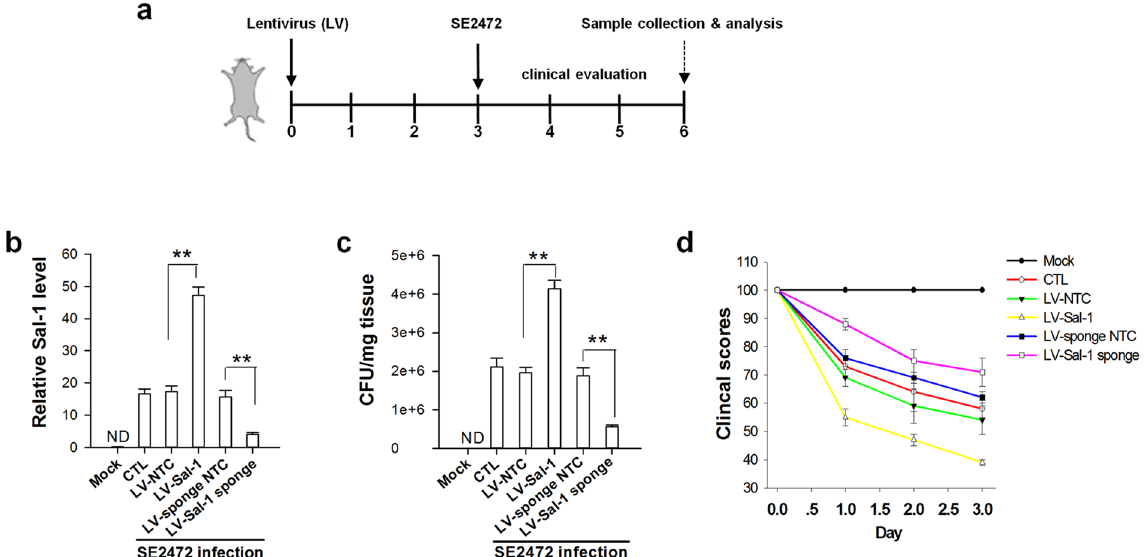
Figure 7. Role of Sal-1 in facilitating Salmonella infection in mice. The lentivirus expressing Sal-1 (LV-Sal-1) or Sal-1 sponge (LV-Sal-1 sponge) were constructed to overexpress or deplete Sal-1 in mouse colon epithelium. Prior to Salmonella infection, the lentiviruses were slowly administered into the lumen of mouse colon via a catheter. Female BALB/c mice (6–8 weeks) were then inoculated intragastrically with Salmonella . ( a ) Experimental design. ( b ) Sal-1 levels in mouse colon tissues. ( c ) Salmonella bacteria count in the mouse colon tissues. ( d ) The clinical scores of the mice after Salmonella infection. ND, not detected. ** P <